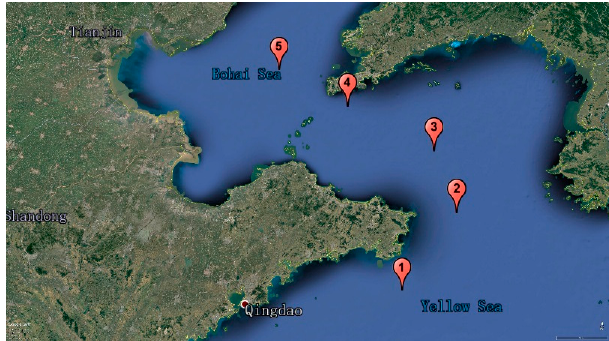
Figure 4. Map of seawater samples in the Bohai Sea and the Yellow Sea area.